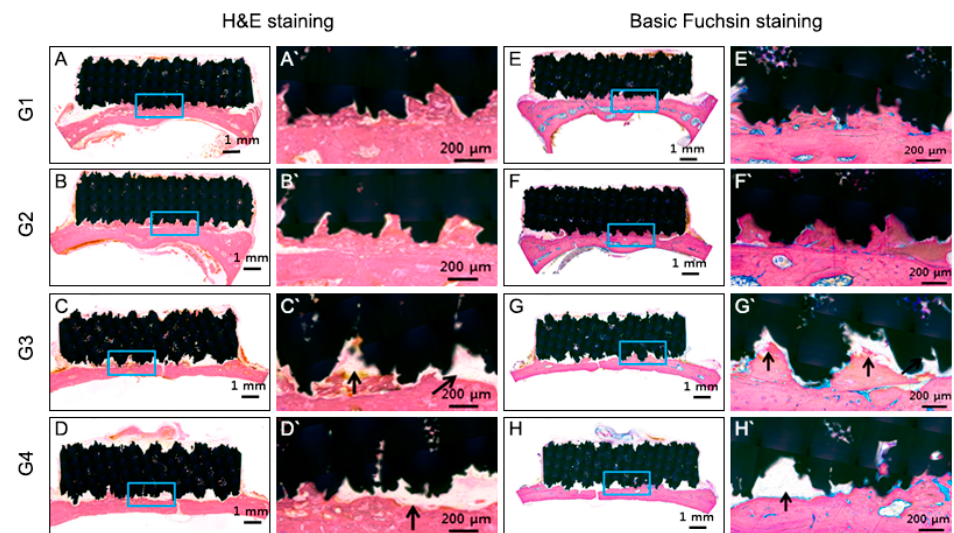
Figure 4. Histological analysis of undecalcified in vivo sample. ( A – D ) H&E staining. ( E – H ) Basic Fuchsin staining. New bone formation into porous scaffold was evident in ( A , B ) and ( E , F ) but not in ( C , D ) and ( G , H ) well organized fibrous connective tissue was obvious between rat calvaria and scaffold (black arrow C , D , G , H ).